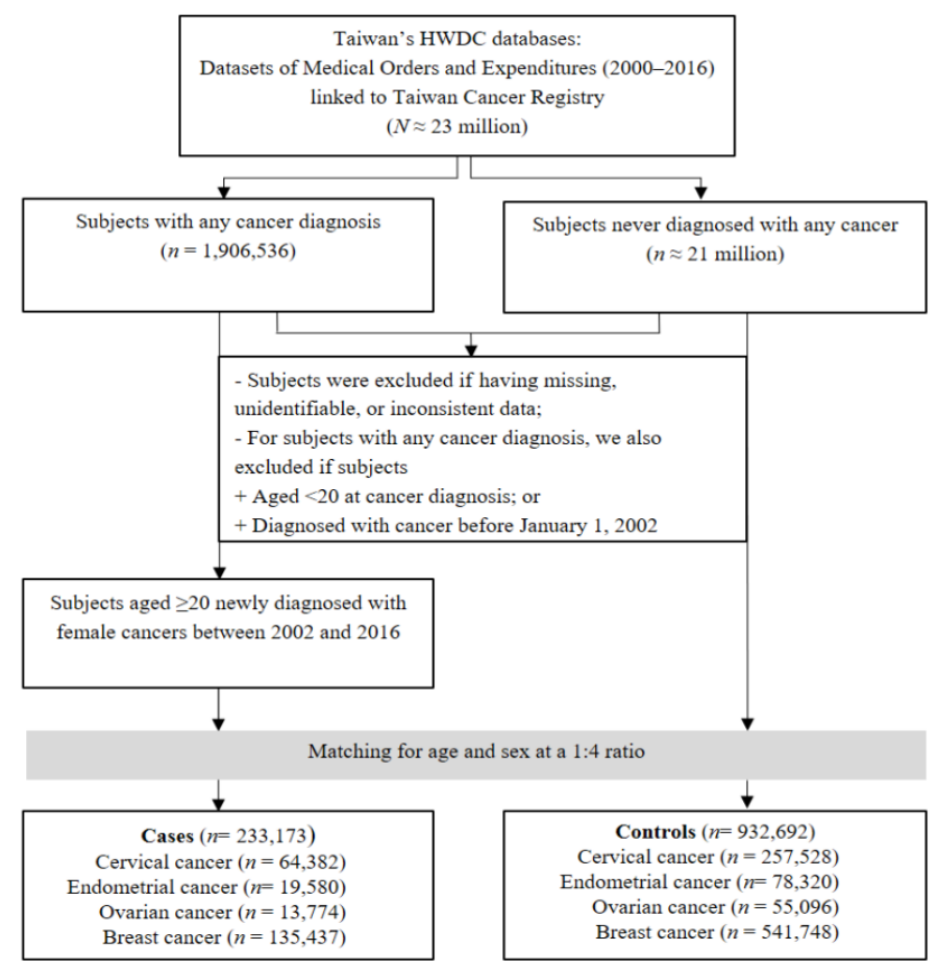
Figure 1. Workflow of the case-control study design.